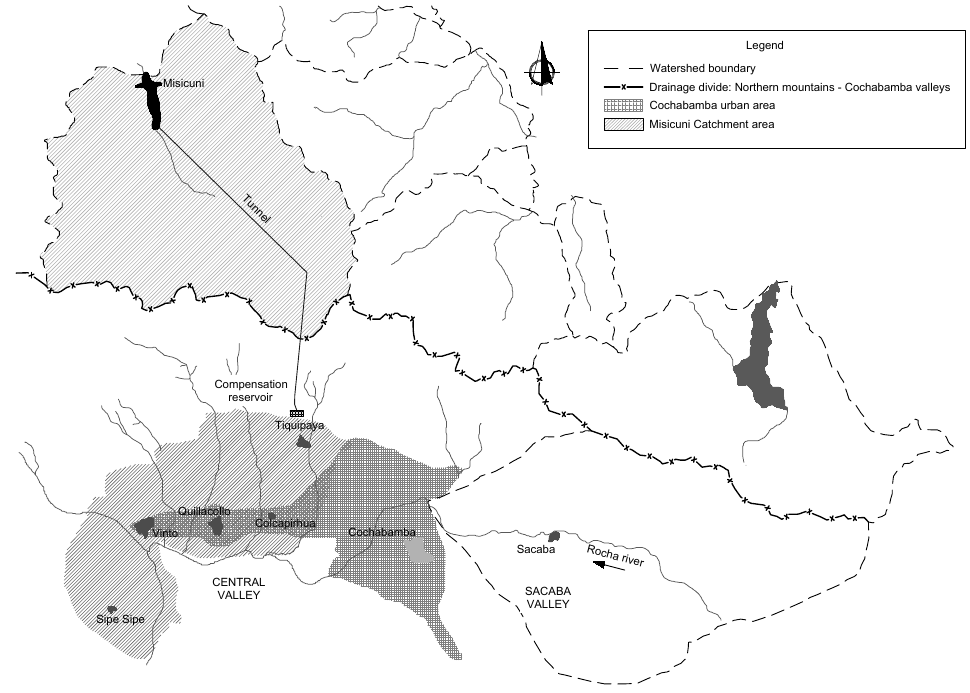
Figure 1. Location of the Misicuni project in relation to the Cochabamba Valley, Bolivia. Elaboration: Paul Hoogendam and Ronald